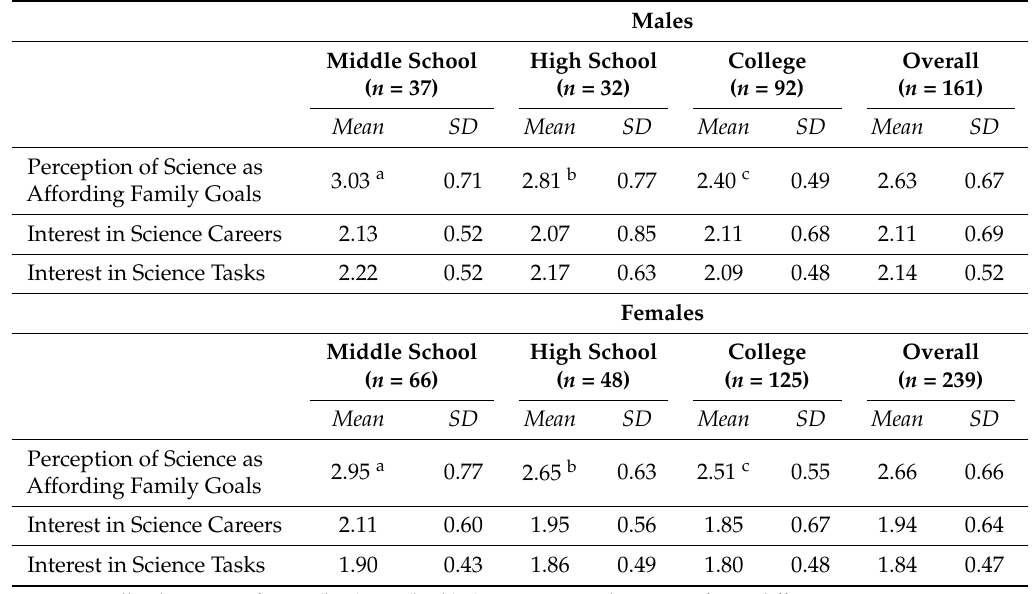
Table 1. Study 1: Means and Standard Deviations for Dependent Variables by Gender and Age Group.